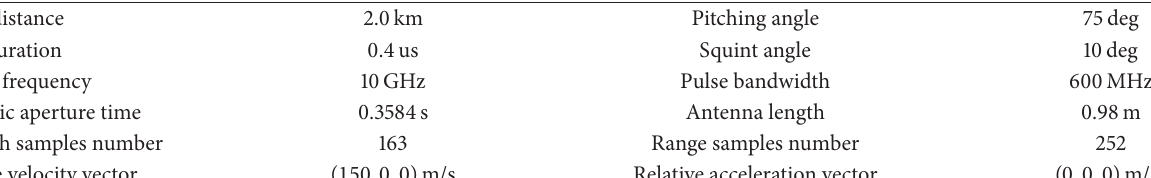
Table 2: Simulation parameters.